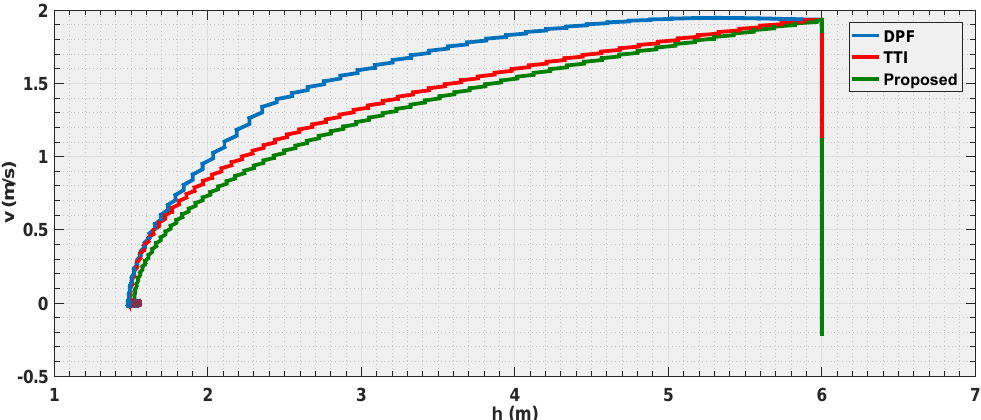
Figure 20. Reference velocity with respect to the distance for the three evaluated algorithms Experiment 3